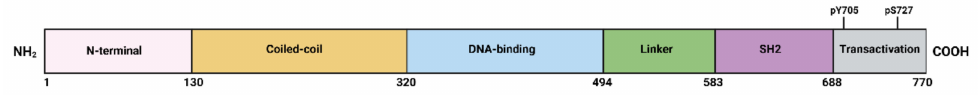
Figure 1. Linear representation of the domain structures of the STAT3 protein. STAT3 is comprised of an N-terminal domain, a Coiled-coil domain, a DNA-binding domain, a Linker, an SH2 domain, and a C-terminal transactivation domain. The C-terminal domain contains a two phosphorylation sites, pY705 and pS727. NH 2 , amino (N) terminus; COOH, carboxy (C) terminus. Figure created in